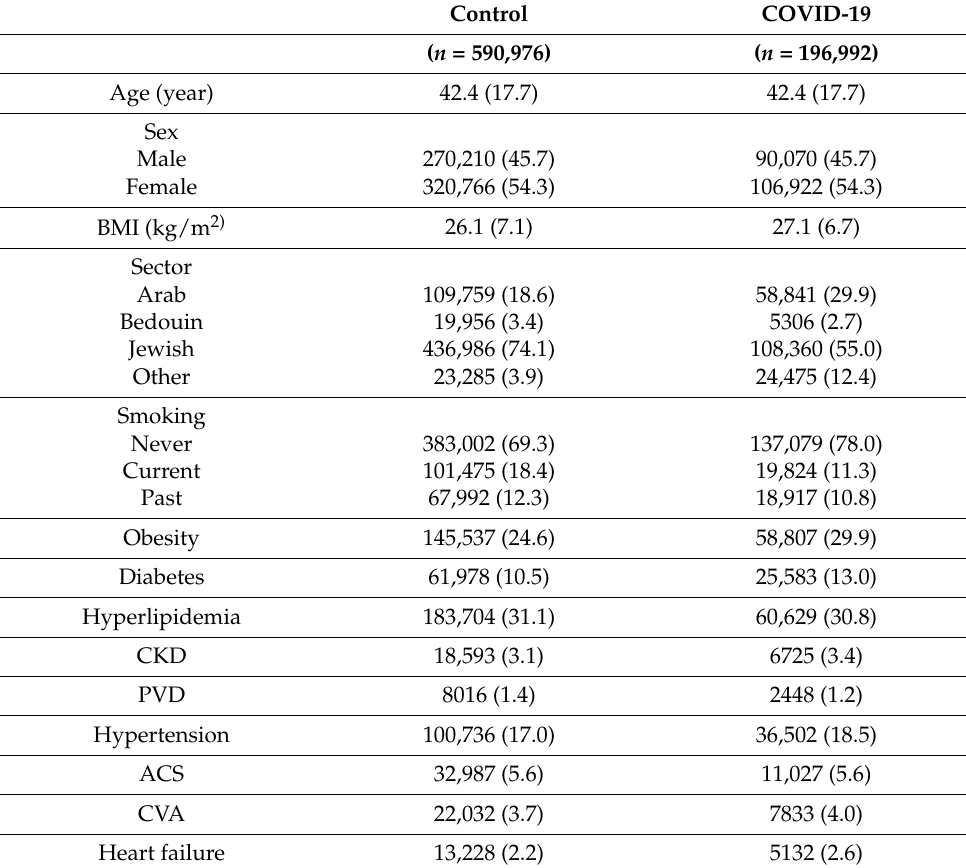
Table 1. Baseline Characteristics of the study population by COVID-19 infection status.